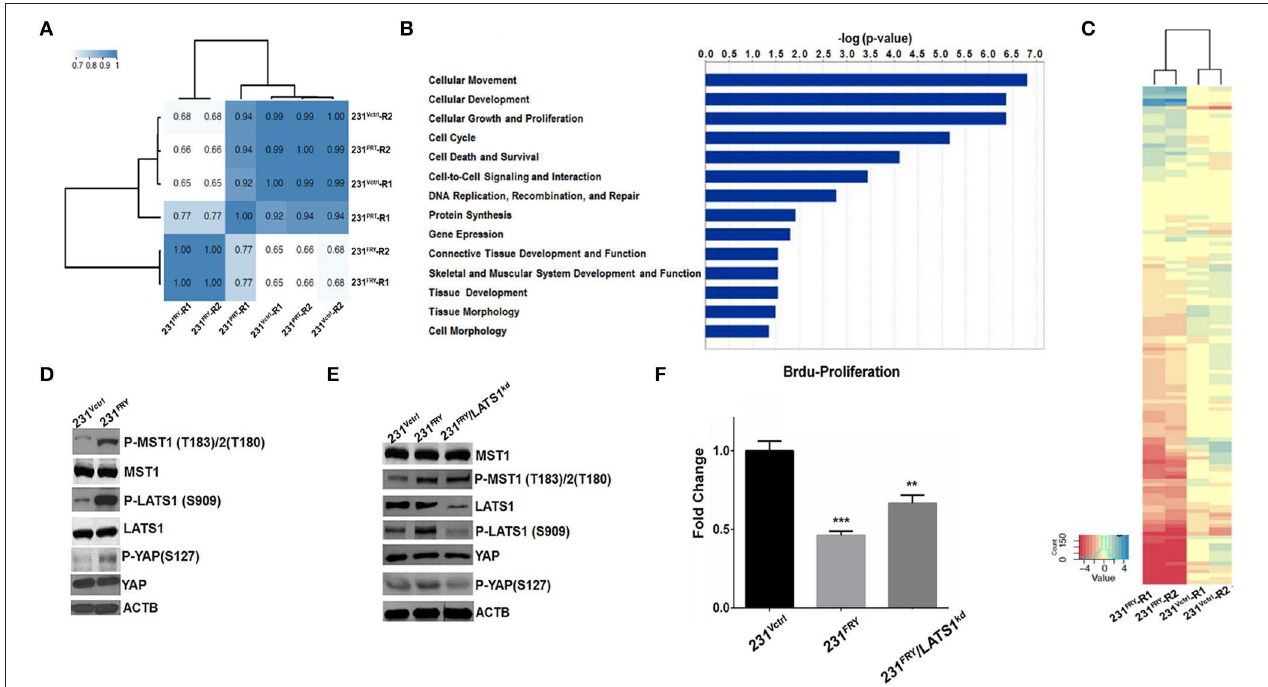
FIGURE 5 | Elevated FRY changes gene expression globally, and its interaction with Hippo/Yap signaling pathway partially contributes to FRY’s antitumor functions. (A) Clustering analysis of global gene expression profiles of 231 PRT , 231 Vctrl , and 231 FRY cells (two replicated for each cell line). (B) Top predicated molecular and cellular functions represented by differentially expressed genes between 231 Vctrl and 231 FRY cells, including cell movement, development, growth and proliferation, cell cycle, and cell death and survival. (C) Cluster heatmap analysis of genes regulated by Hippo/Yap kinase cascade. The majority of these genes were significantly downregulated in MDA-MB-231 cells expressing ectopic FRY. (D) Representative immunoblot images of total and phosphorylated MST1, LATS1 and YAP in 231 Vctrl and 231 FRY cells were shown. (E) MDA-MB-231 expressing ectopic FRY cells were transfected with non-specific siRNA (siRNA-NS), or siRNA-LATS1 for 24h. Total and phosphorylated MST1, LATS1 and YAP were evaluated. (F) siRNA-LATS1 transfection in 231 FRY cells led to a compromised but not complete loss of FRY’s effects in inhibiting proliferation of MDA-MB-231 cells. Results are representative of three independent experiments. Bars represent the mean ± SEM of three independent experiments. Statistical significance: ** P < 0.01; *** P <